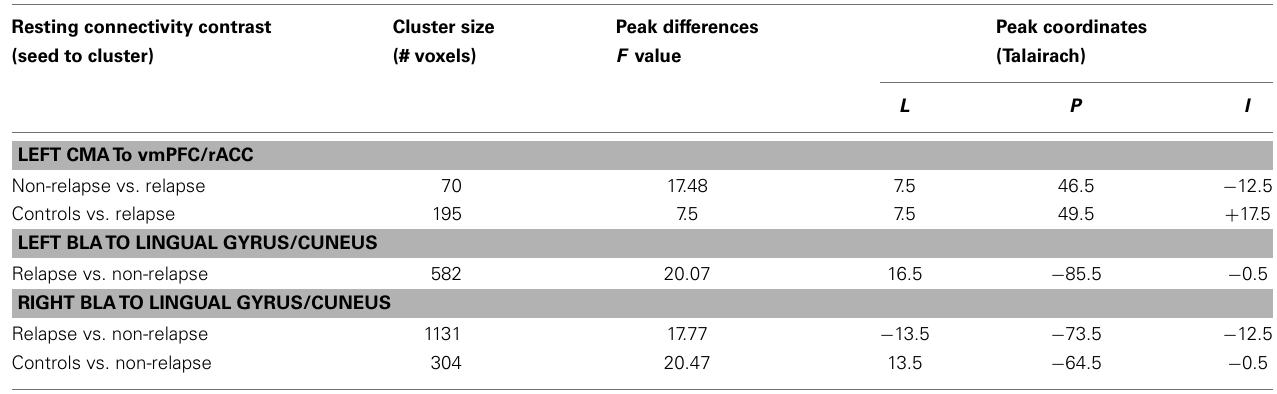
Table 2 | Summary of significant clusters arising from whole-brain group contrasts.